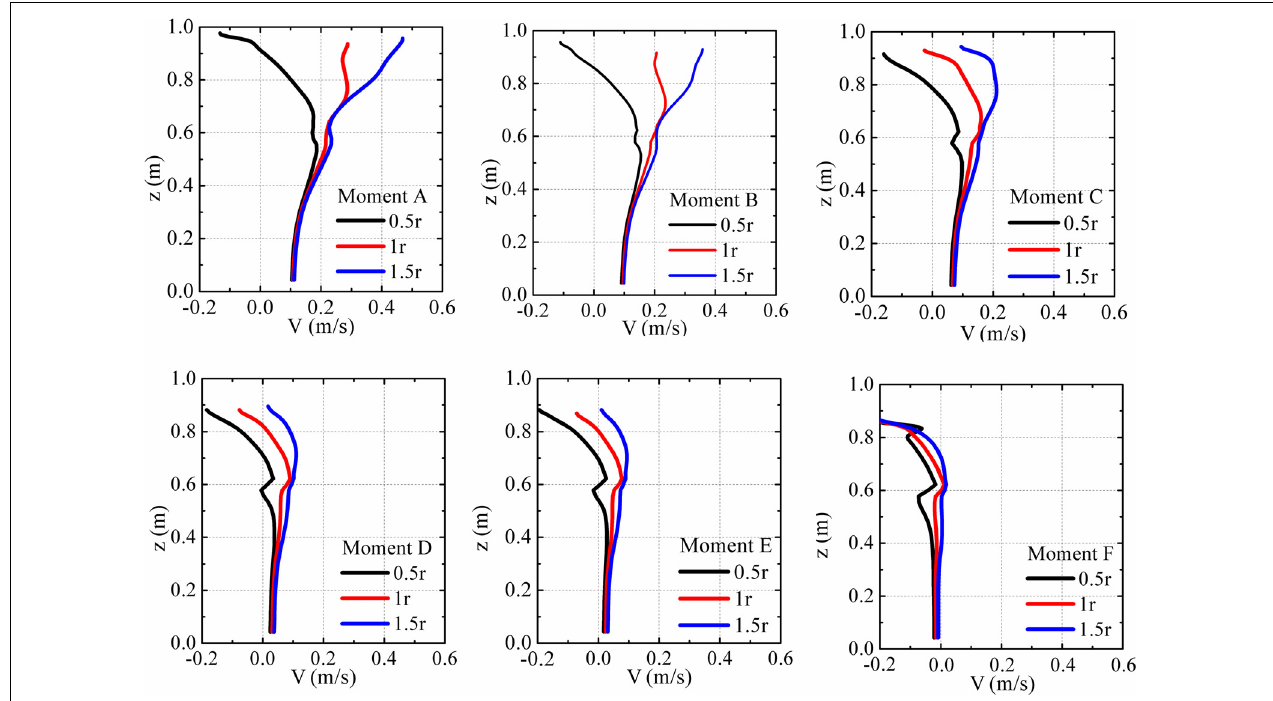
FIGURE 9 | Distributions of flow velocity during SLC.